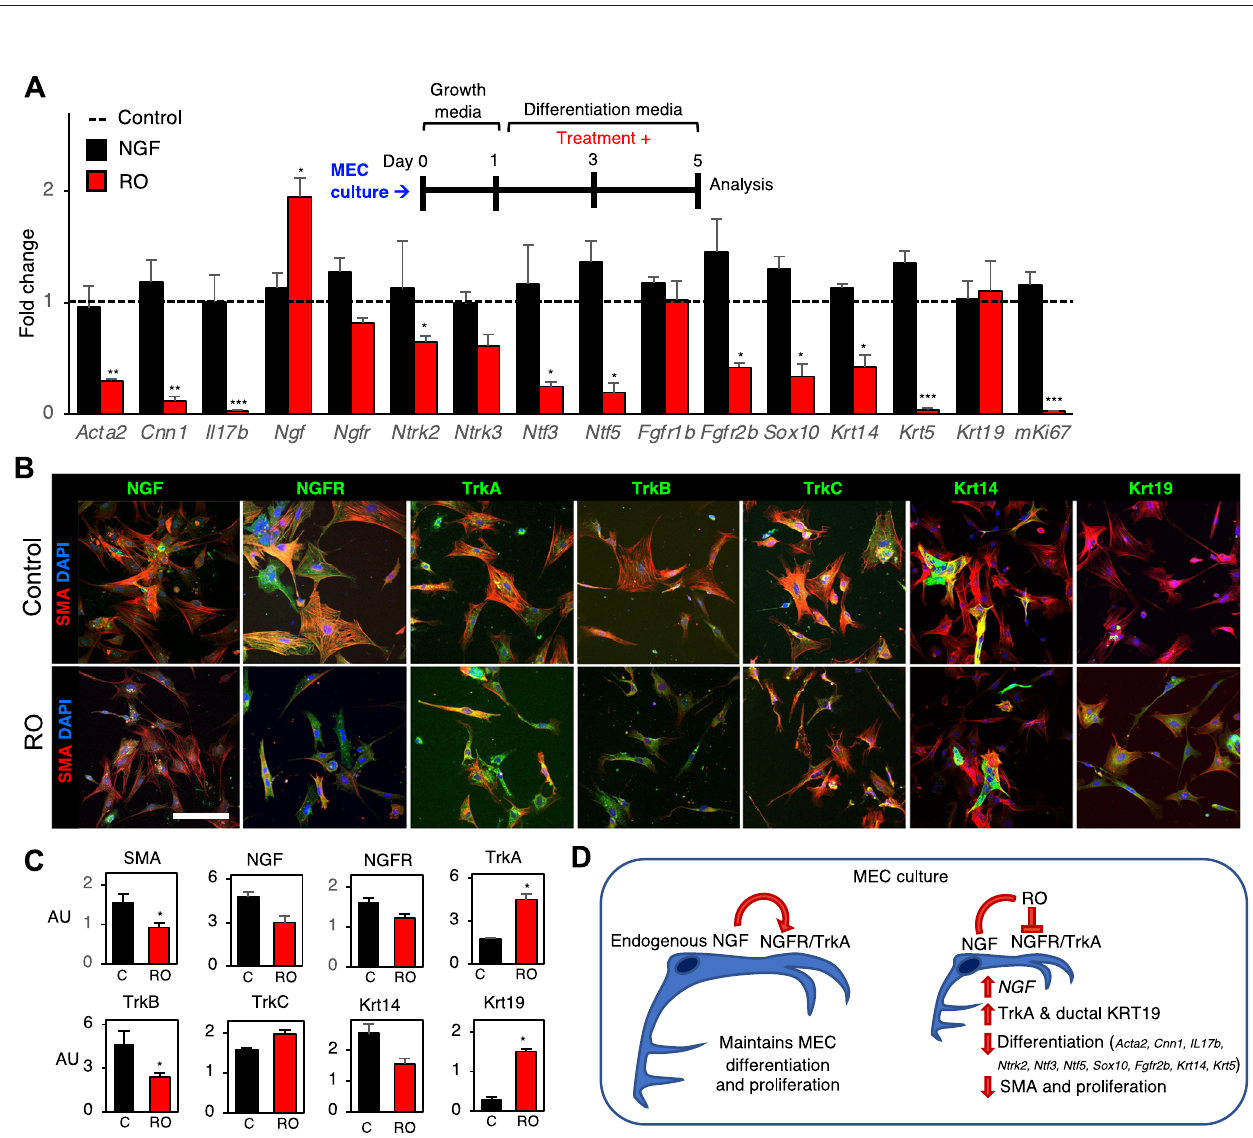
Fig. 6 Dysregulation of neurotrophin receptors in MECs is associated with abnormal MEC differentiation and morphology. A Experimental setup of murine MEC culture treated with exogenous NGF or RO for 48 h. PCR results showing fold change gene expression of selected MEC and duct genes 48 h post-treatment with NGF or RO ( n = 4 per group). Statistical signi fi cance (* p < 0.05; ** p < 0.01; *** p < 0.001; Unpaired t-test compared to each control). B Immunostaining of MEC culture treated with RO for 48 h, with antibodies to NGF, neurotrophin receptors, KRT14 and KRT19 (all Green). All cultures were stained with SMA (red) and DAPI (blue). Scale bar = 150 µm. C Relative quantitation of MEC immunostaining from B , normalized to nuclei staining. Data is shown as mean + / − SEM. Two-tailed unpaired t -test was used. D Summary of NGF signaling in MEC